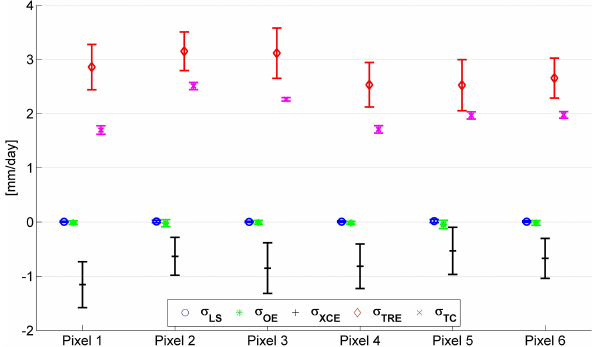
Figure 8. Decomposition of TC-based estimates of RMSE in the NEXRAD product across the six pixels shown in Fig. 1. Error bars show 1 standard deviation of the estimates from a bootstrap run with 100